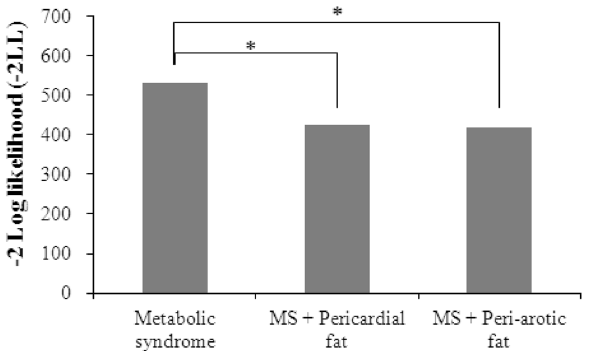
Figure 1. The incremental value of likelihood ratio test in discriminating fatty liver diagnosis (* indicates P values of delta LR test < 0.001).